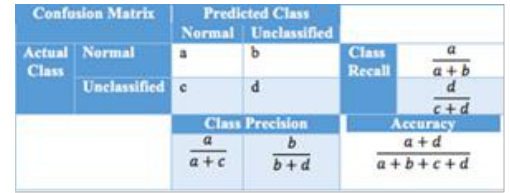
Figure 3. Confusion Matrix Table with 2 Classes